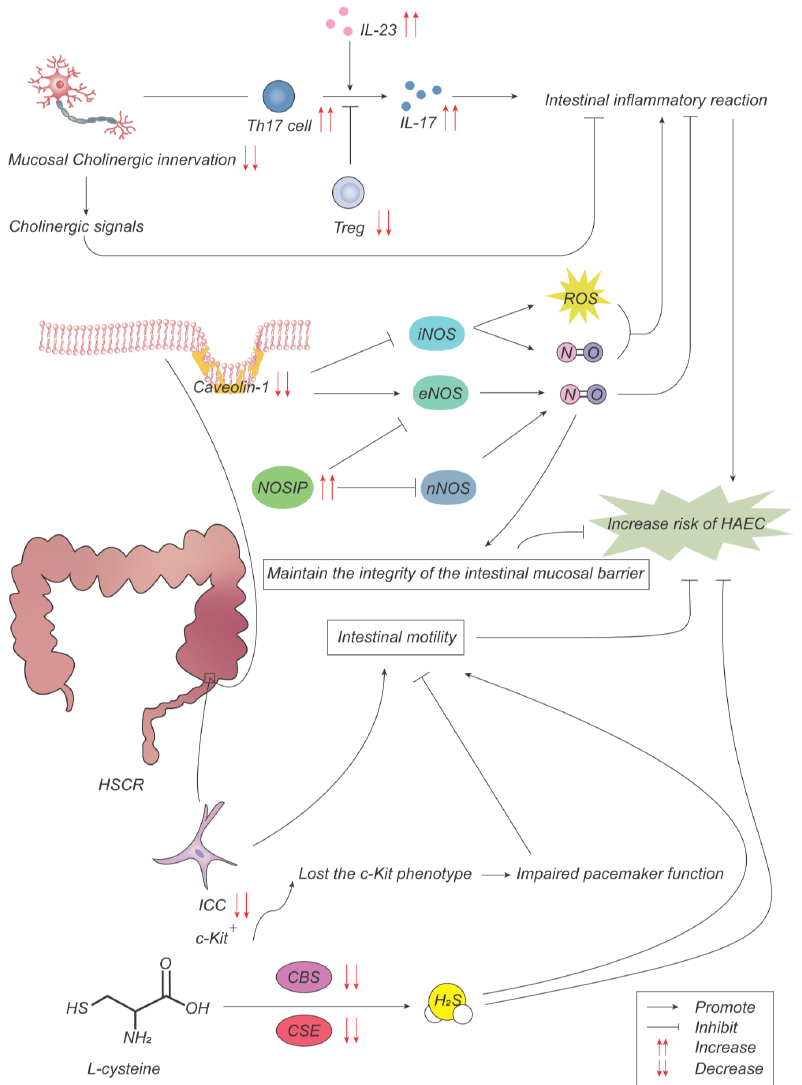
Figure 3. Pathogenesis advances in ENS. With a low cholinergic innervation degree in colon mucosa, Th17 cells and Treg cells regulate intestinal inflammatory response through the production of IL-17 and IL-23, promoting the development of HAEC. The decreased expression of caveolin-1 (Cav-1) results in the overactivation of inducible NO synthase (iNOS), which produces NO to promote inflammatory response while decreasing the inhibition of endothelial NOS (eNOS) on inflammatory response. The increased expression of NOS interacting protein (NOSIP) promotes inflammatory response and destroys the mucosal barrier by inhibiting NO production of neuronal NOS (nNOS) and eNOS. Interstitial cells of Cajal (ICCs) lose the c-Kit phenotype, resulting in impaired pacemaker function and intestinal motility. Cystathionine- β -synthase (CBS) and cystathionine- γ -lyase (CSE) are two key enzymes in the synthesis of hydrogen sulfide from L-cysteine. The decreased expression of CBS and CSE reduces gastrointestinal peristalsis and promotes the inflammatory